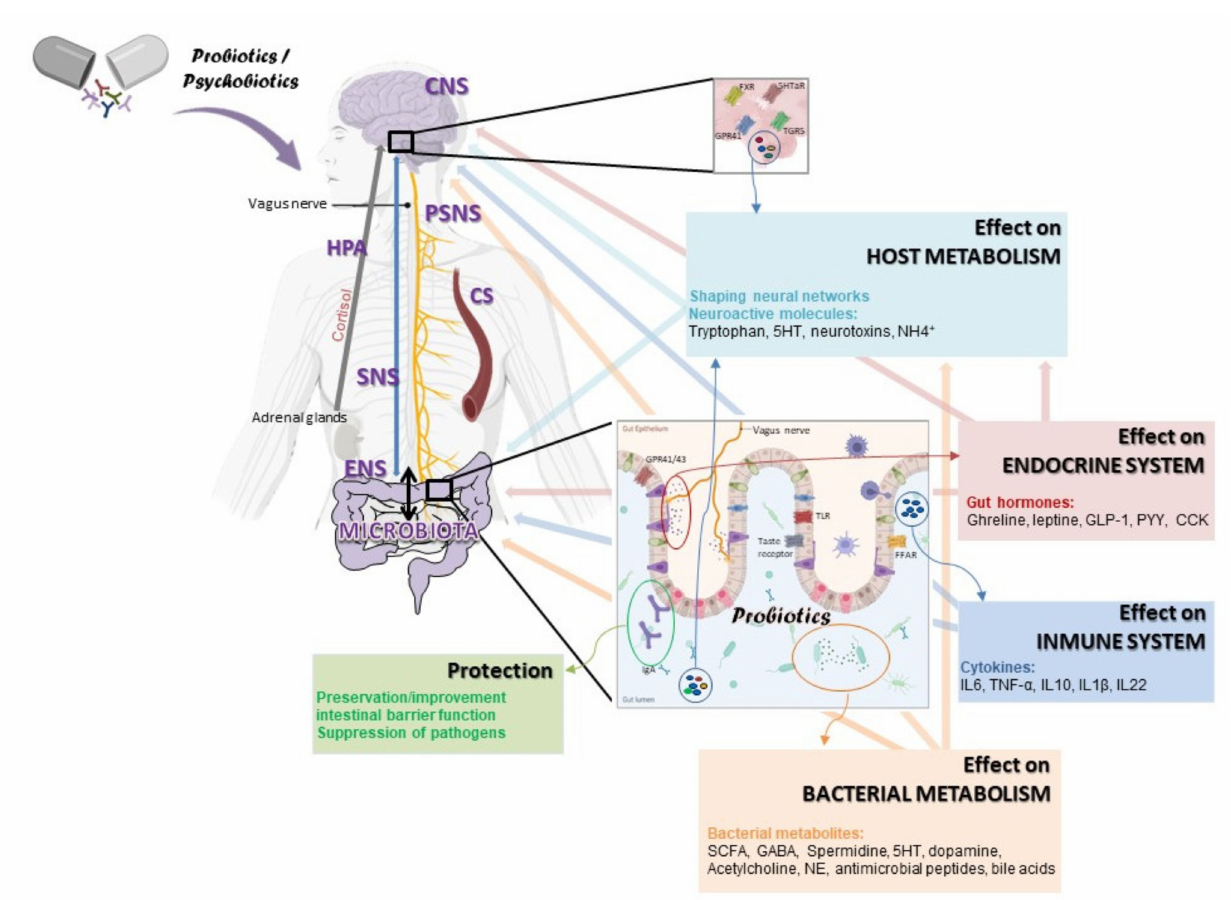
Figure 3. Routes of communications between gut microbiota and brain and mechanisms through probiotics keep homeostasis between both systems. CNS: central nervous system; SNS: sympa- thetic nervous system; PSNS: parasympathetic nervous system; ENS: enteric nervous system; HPA: hypothalamic-pituitary-adrenal; CS: circulatory system; GABA: α -aminobutyric acid; SCFA: Short chain fatty acids; 5HT: serotonin; NE: norepinephrine; NH4+: ammonium; GLP-1: glucagon-like peptide -1; PYY: peptide YY; CCK: cholecystokinin; IL: interleukin; TNF- α : tumor necrosis factor α ; TLR: toll-like receptors; FXR: bile acid farnesoid X receptor; TGR5: bile acid Takeda G-protein-coupled receptor 5; GPR41/43: G protein-coupled receptors 41/43; 5HTa R: serotonin receptor. Figure created using BioRender